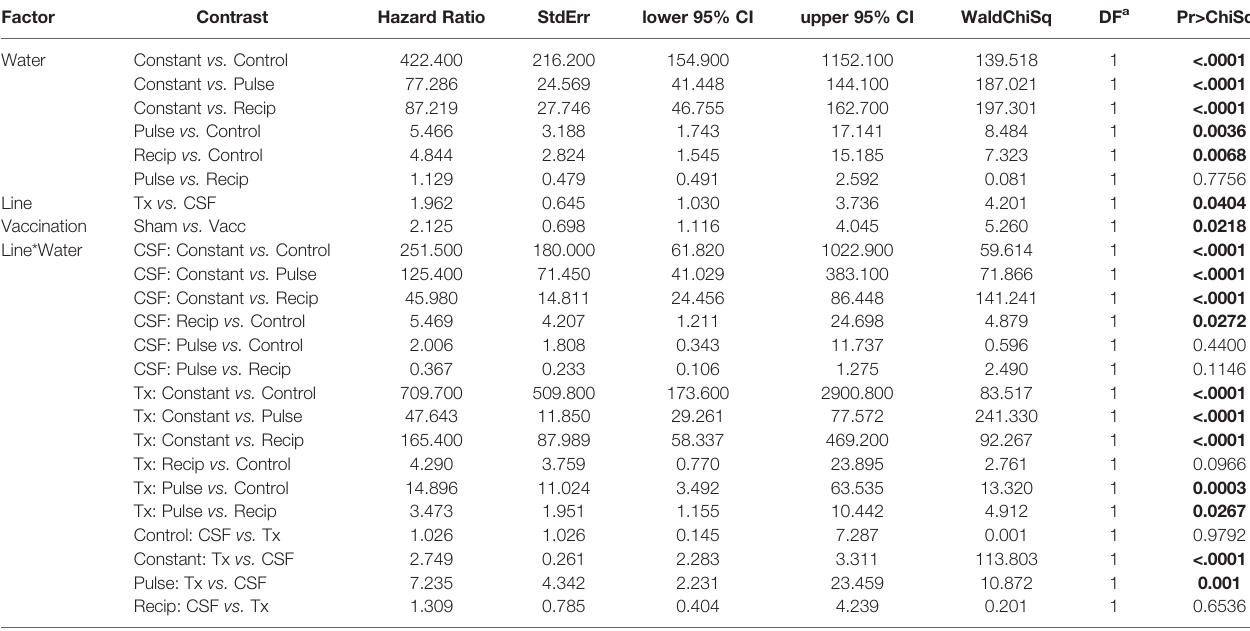
TABLE 3 | Model contrasts, hazard ratio and P-value for survival analysis comparisons from fi eld experiment. Factor Contrast Hazard Ratio StdErr lower 95% CI upper 95% CI WaldChiSq DF a Pr>ChiSq b Water Constant vs. Control 422.400